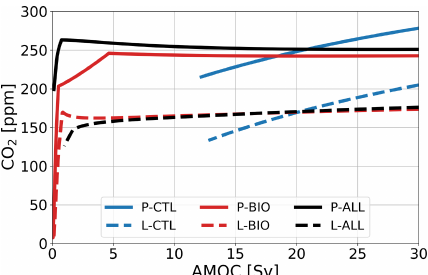
Figure 2. Atmospheric p CO 2 in parts per million under varying AMOC strength in sverdrups for three reference cases (blue: no feedback; red: with biological feedback; black: all feedbacks) in two configurations (solid: PI; dashed: LGM). All branches repre- sent stable fixed